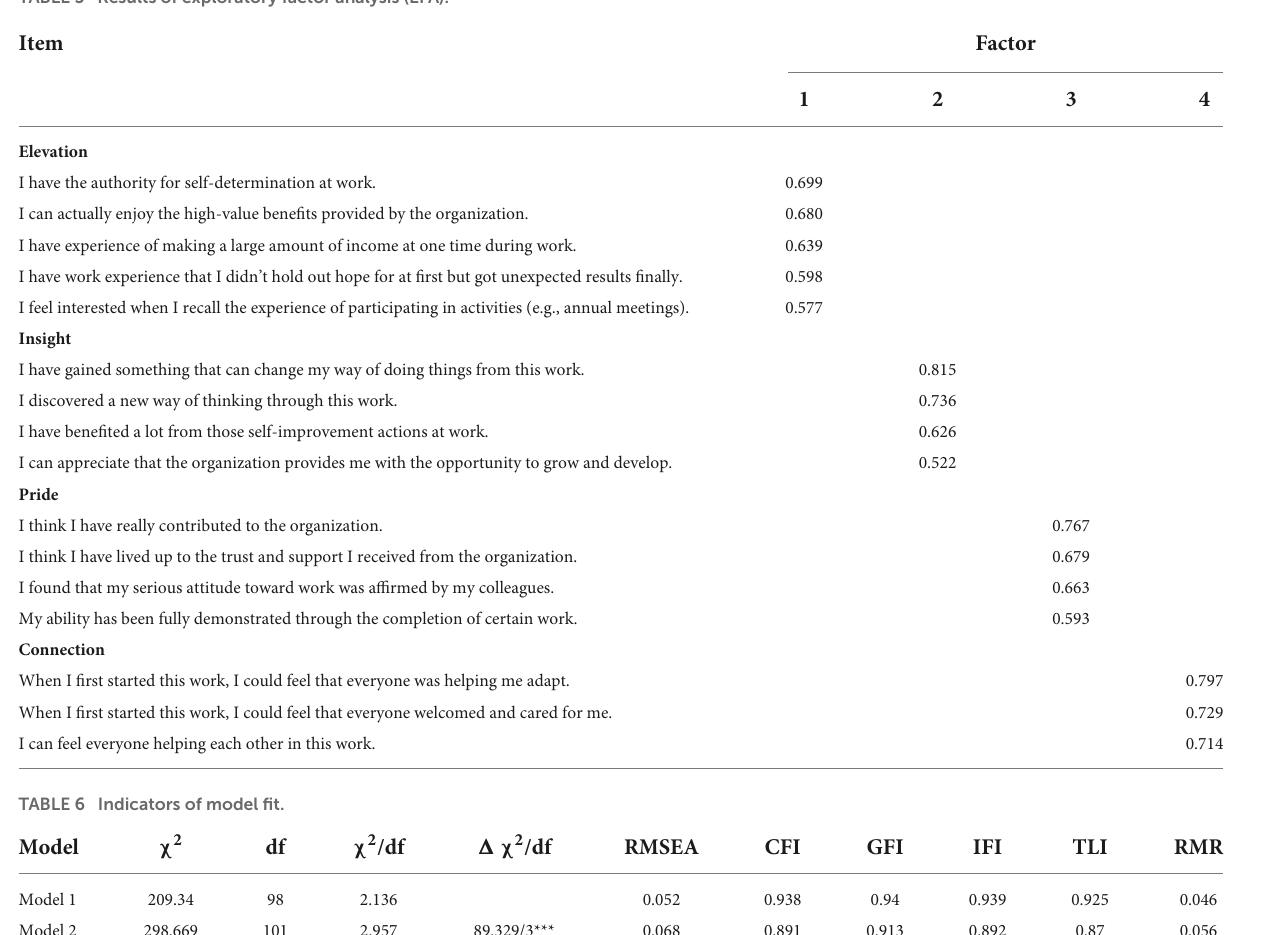
TABLE 5 Results of exploratory factor analysis (EFA).